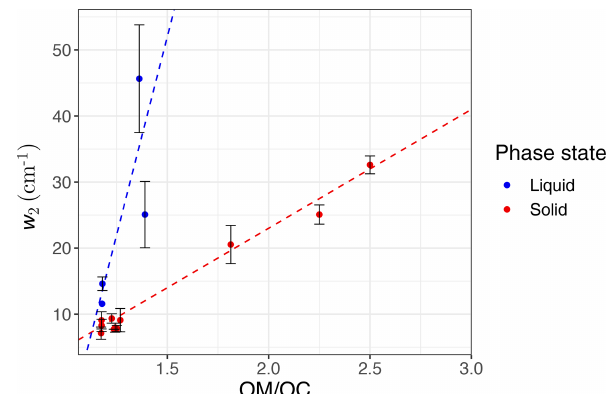
Figure 9. The average value of second peak width ( w 2 ) measured for each compound in the calibration set versus the OM / OC ra- tio, colored based on compound phase state at laboratory condition (25 ◦ C). Error bars show ± 1 standard error from the average, and dashed lines are visual guides.